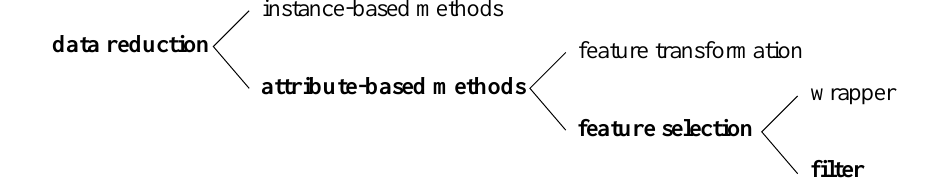
feature transformation wrapper feature selection